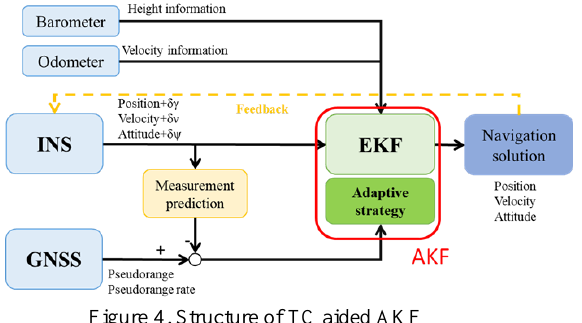
Figure 4. Structure of TC aided AKF